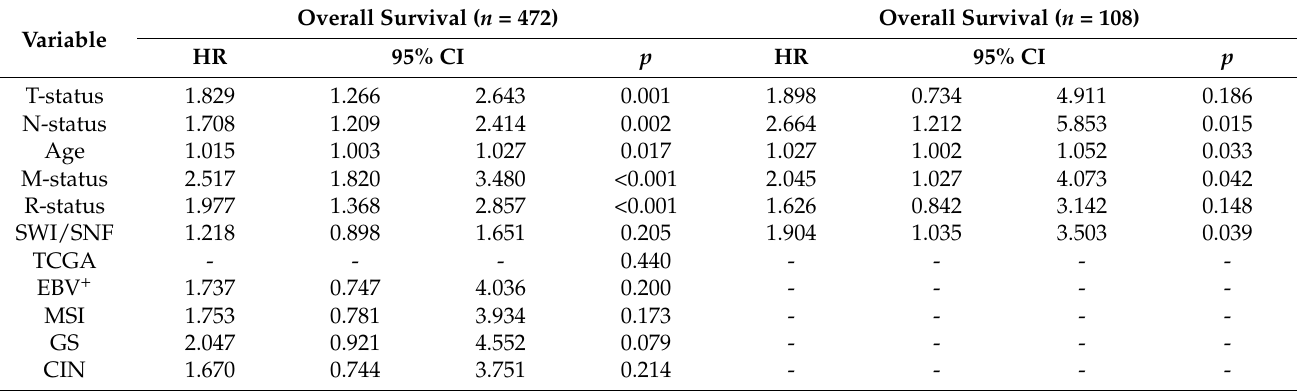
Table 2. Cox regression analyses of SWI/SNF status in all cases and in GS